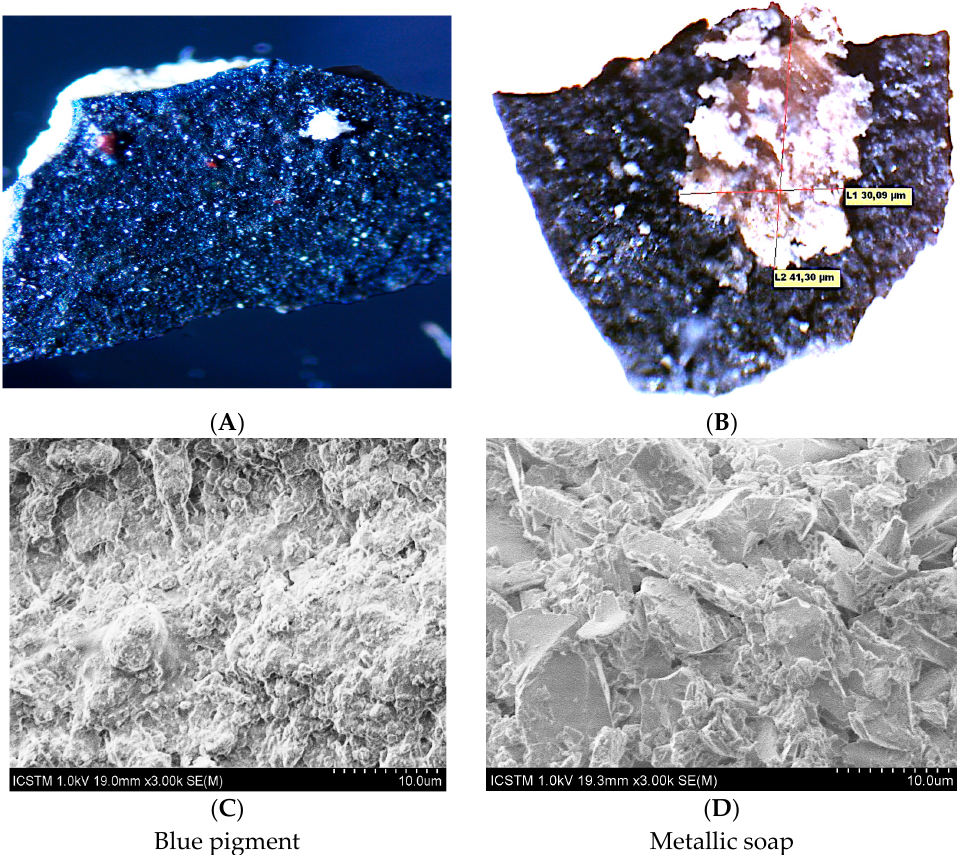
Figure 4. Stereomicroscopy of blue pigment with white deposit (A,B) images and SEM images of blue pigment (C) and of the white deposit (D) .